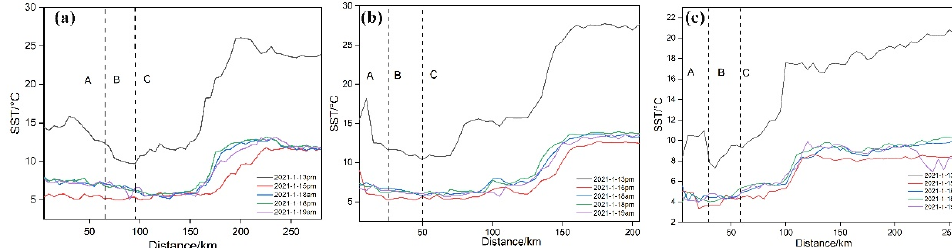
Figure 5. The effect of the cold wave on the SST field from inside the mouth to outside the mouth (using the January 2015 cold wave as an example), where A, B, and C represent inside the mouth, the mouth opening, and outside the mouth, respectively. ( a – c ) represent the three profiles P1, P2, and P3, respectively.